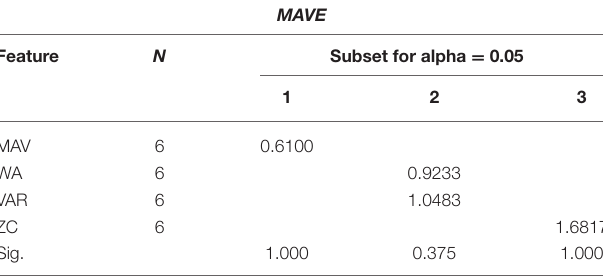
TABLE 6 | The results of the Tukey HSD for